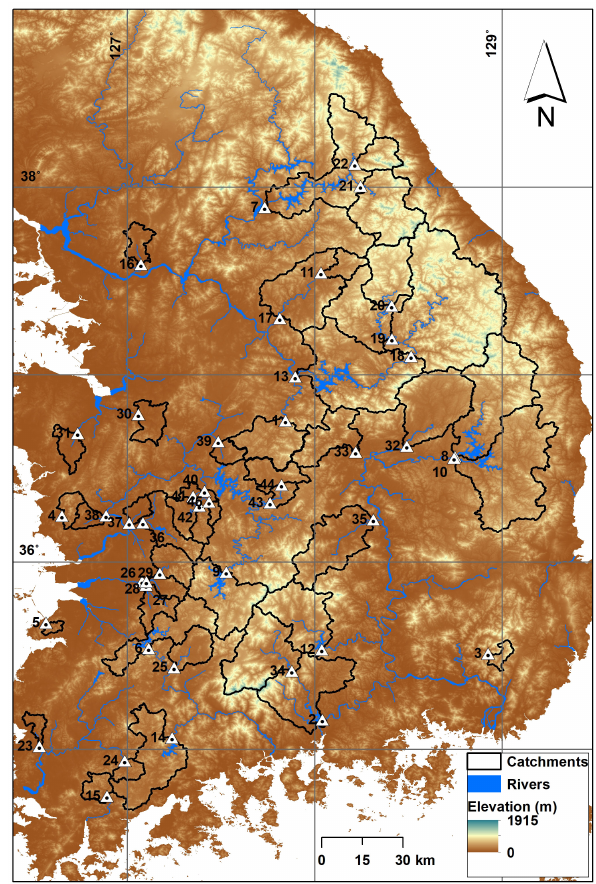
Figure 1. Locations of the study catchments in South Korea. The numbers are labelled at the outlet of each